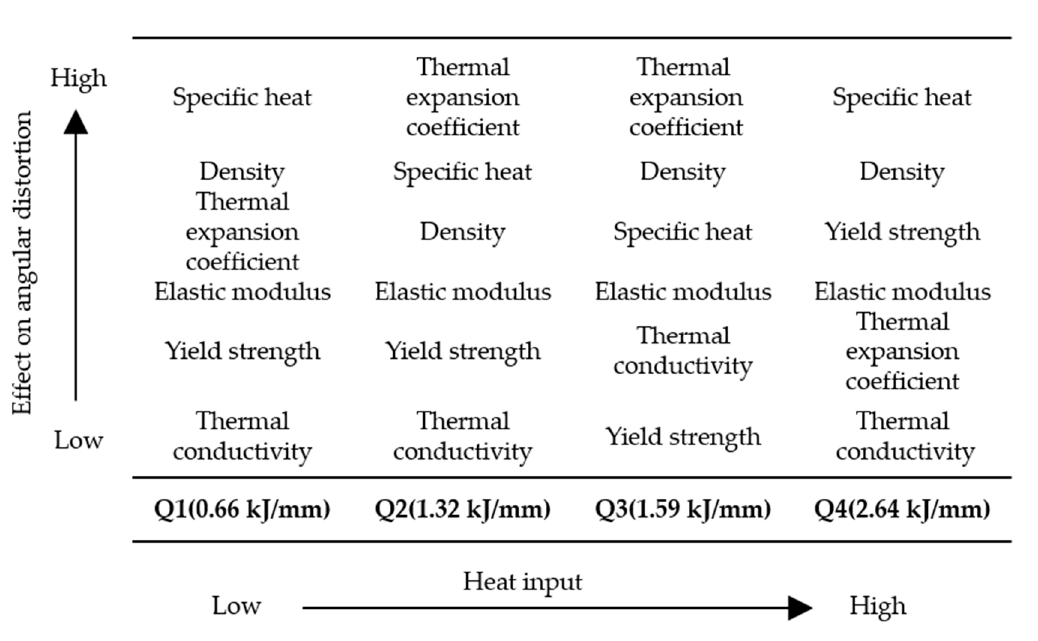
ff ects of material properties on angular Figure 17. Order of effects of material properties on angular distortion. Figure 17. Order of e